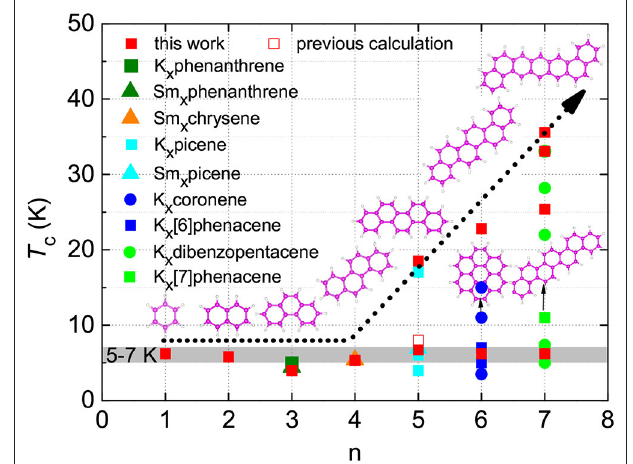
FIGURE 4 | Superconducting transition temperatures of aromatic hydrocarbons. Variation of superconducting transition temperature T c with the number of benzene rings (n) for various aromatic hydrocarbons. The gray region is the guide for eyes. Solid red squares represent our predicted results, while the hollow red square implies the predicted result by Casula et al. [ 22] Other data are taken from experiments. show the superconducting transition at temperatures around 7 K [6]. In particular, Sm-doped phenanthrene, chrysene and picene show the superconductivity around T c ∼ 5 K